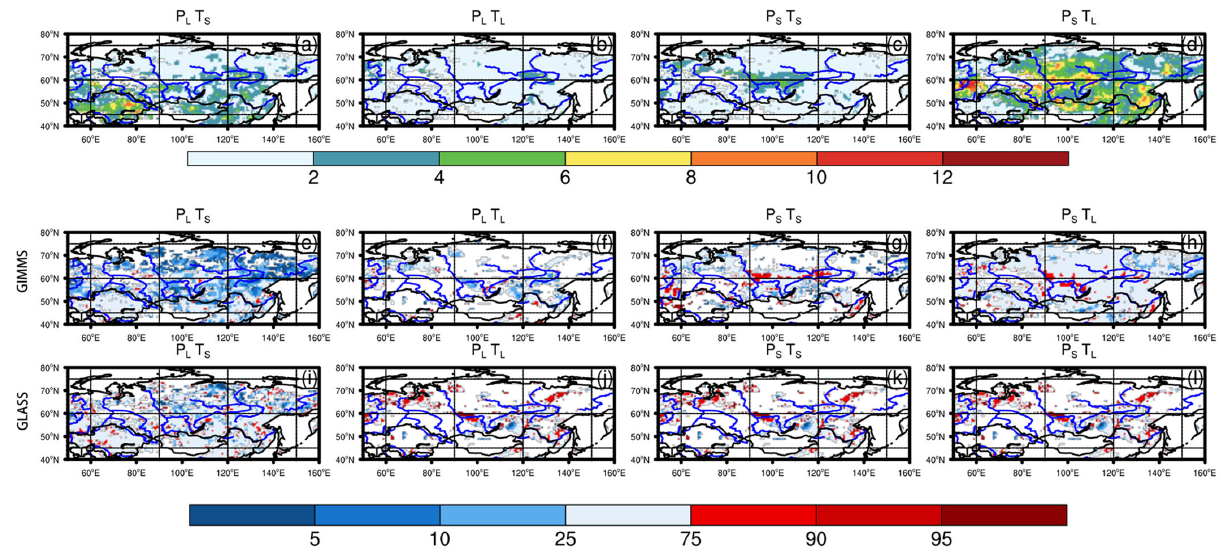
Figure 11. Frequencies of the four types of compound extreme precipitation and temperature climates ( a – d ) and the corresponding average percentiles of the GIMMS LAI ( e – h ) and GLASS LAI ( i – l ).